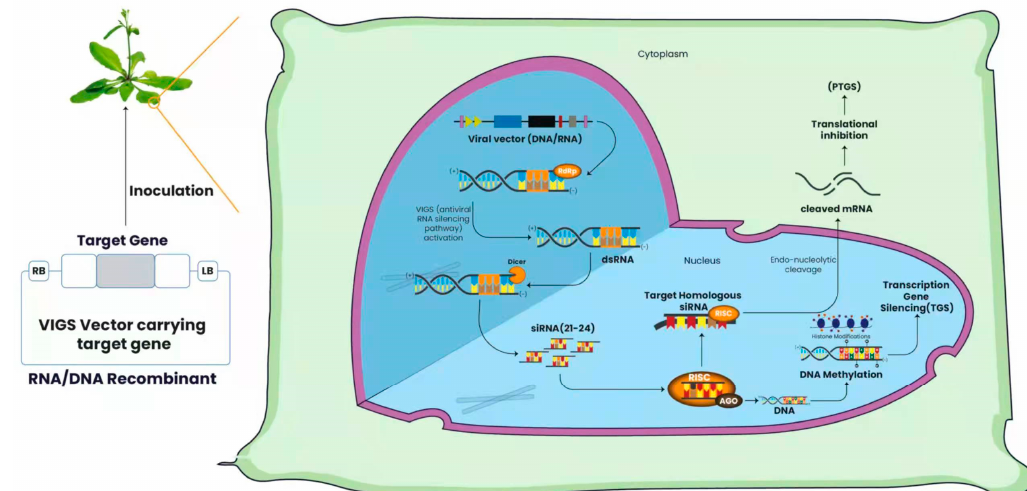
Figure 1. Molecular mechanisms of VIGS viral vectors (DNA or RNA) injected into plants containing the sequence of the intended gene. VIGS activates when the endogenous RDRP generates viral dsRNA, which are cleaved into small (21–24 nt) siRNAs by Dicer. Then, amplified siRNAs join with the AGO protein to form RISC, these siRNAs being used by RISC to precisely connect with homologous RNA in the cell, triggering endo-nucleolytic cleavage and translational inhibition of the cognate target mRNA, resulting in PTGS. The AGO complex also interacts with target DNA molecules in the nucleus, triggering transcriptional repression and TGS by DNA methylation and histone modifications. RNA-directed RNA polymerase (RDRP), transcriptional gene silencing (TGS), RNA Induced Silencing Complex (RISC), and short interference RNAs (siRNAs).